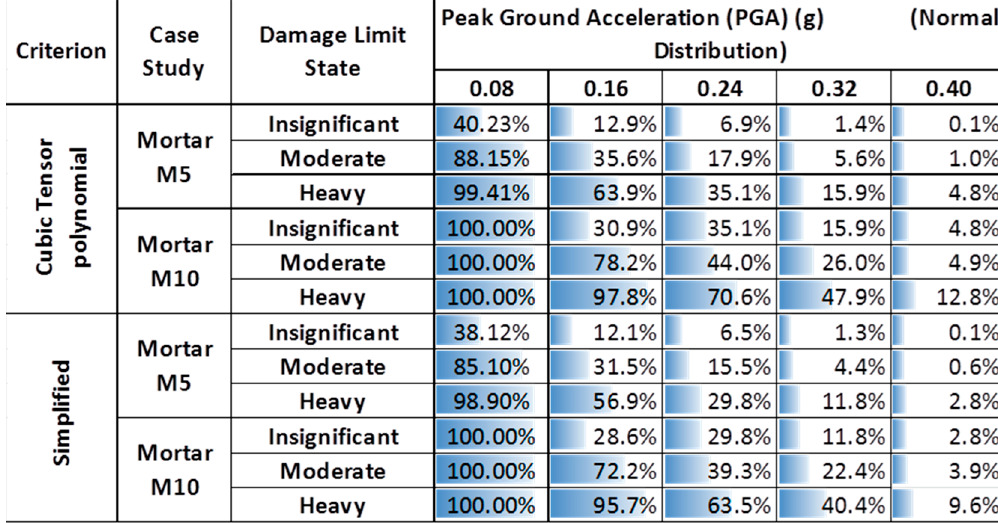
Figure 15. Seismic vulnerability reduction of the structure for the two rehabilitation scenarios (normal